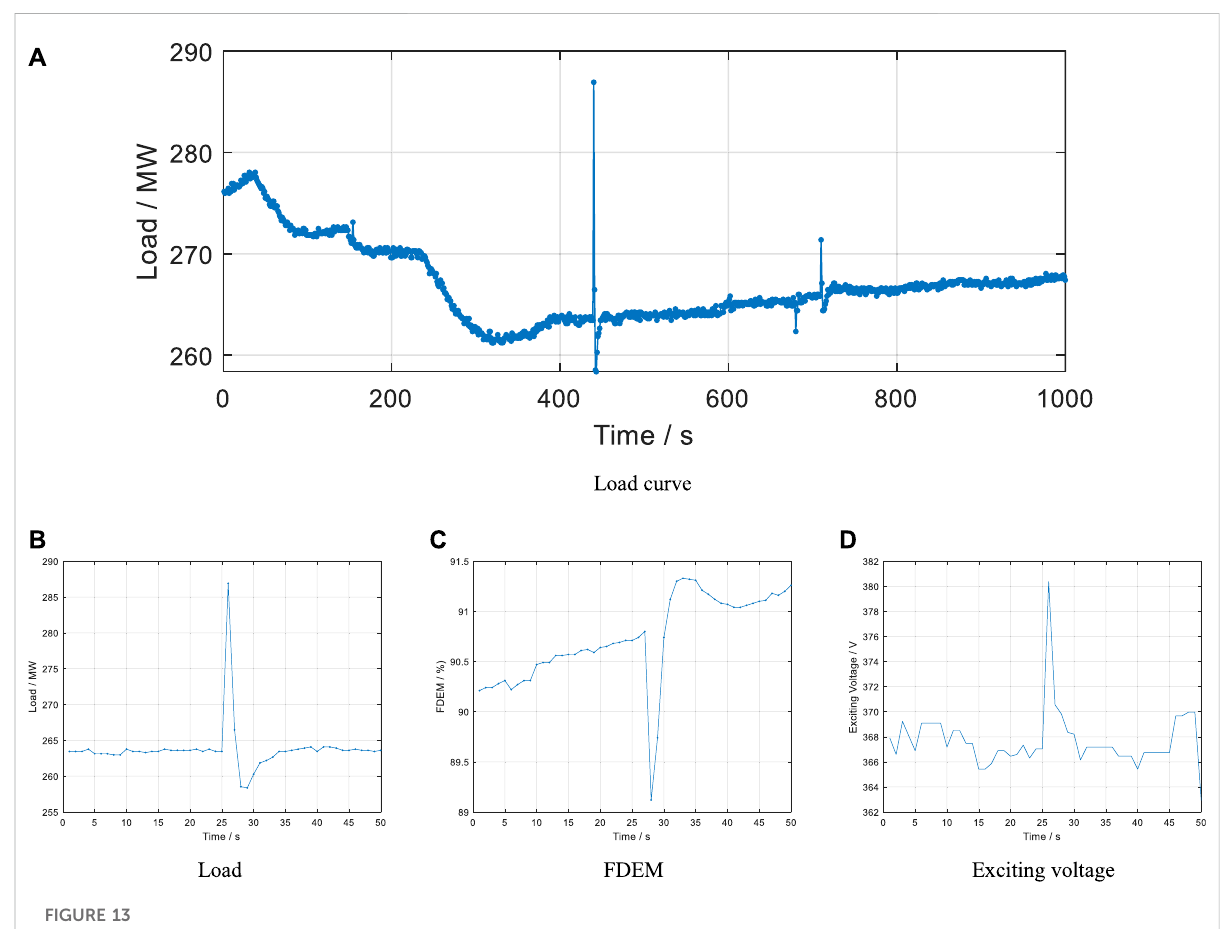
Figure 9A showed a sudden load drop of approximately 13.26 MW at 7405s – 7409s. The pressures of the main steam and the steam after GS (Figure 9B) suddenly increased and decreased respectively. However, the FDEM curve and valve opening curves of each GV in Figure 9C show a stable state, indicating that the hardware looseness fault caused the valve disk to drop and change the input steam parameters of the steam turbine. The fl ow characteristic curve